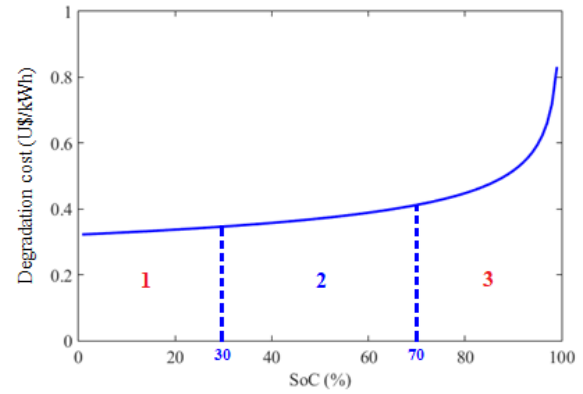
Figure 3. Battery degradation cost model [28].